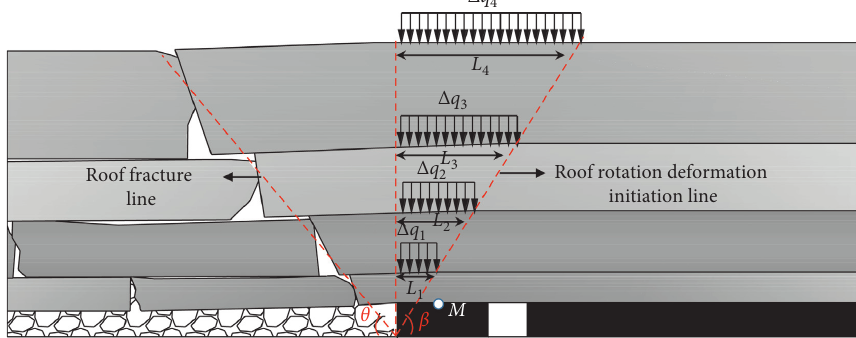
Figure 4: Additional load distribution of the cantilever block along the goaf